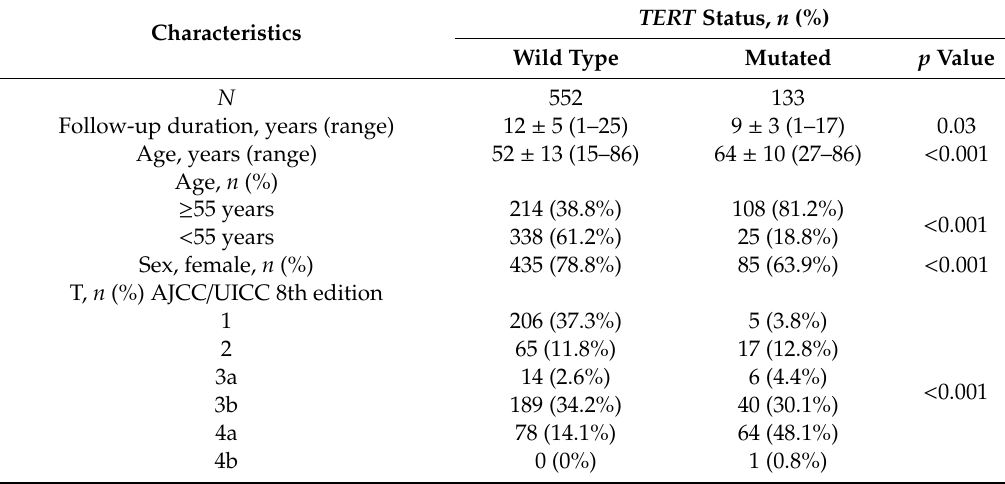
Table 4. Characteristics of patients with and without TERT promoter